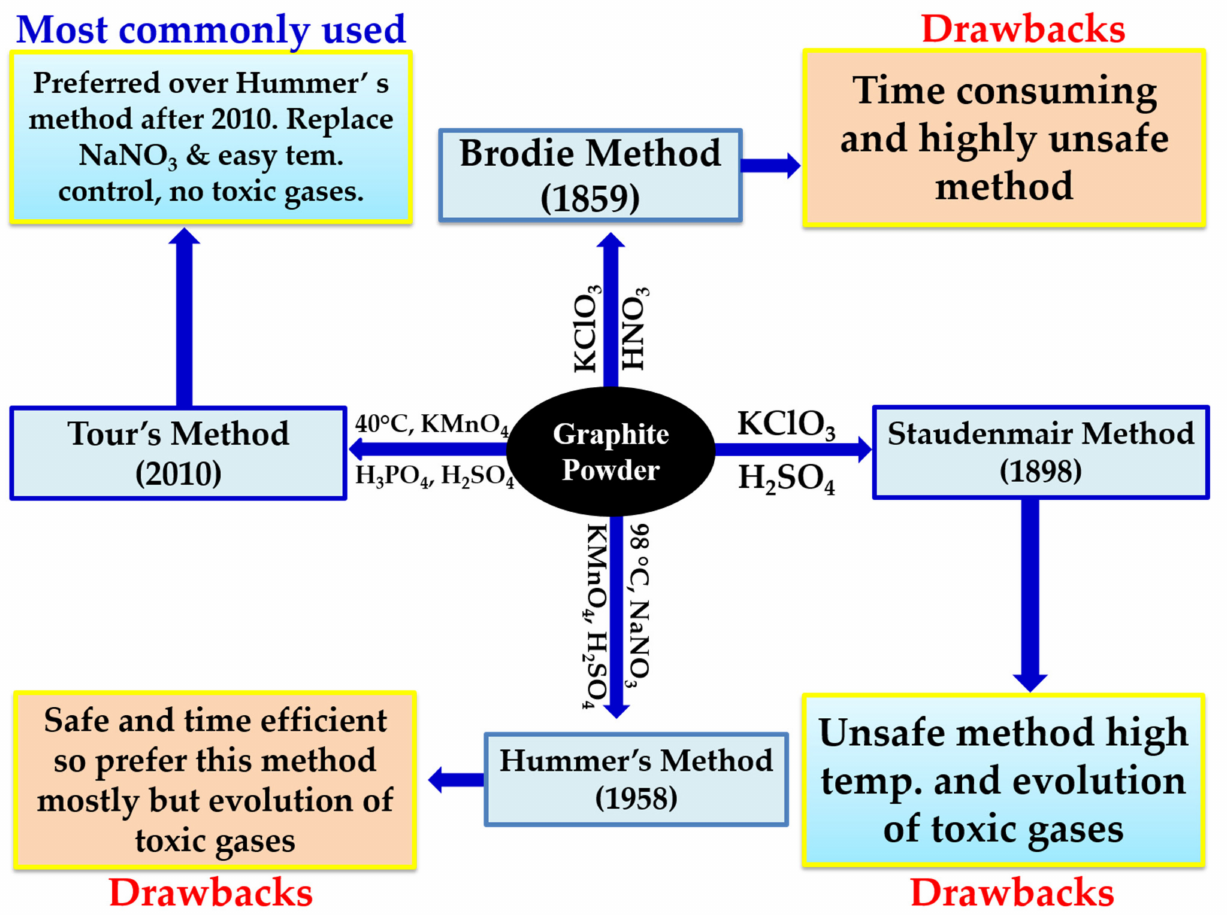
Figure 11. Schematic representation of the synthesis of graphene oxide with different methods. In 1958, Hummer reduced the reaction time from 2 days to 12 h by using KmnO 4 as the oxidizing agent instead of KclO 4 , followed by the addition of sodium nitrate, but the problem of toxic gases still remains a challenge [98]. Further, in 2010, at Rice University, Tour’s group [102] replaced sodium nitrate with phosphoric acid and increased the amount of KmnO 4 . This improvement made the process eco-friendly, as it completely stops the release of toxic gases such as NO 2 , N 2 O 4 or ClO 2 , along with easy temperature control and better yield [102]. In addition to this, the GO suspension obtained was treated with hydrogen peroxide (H 2 O 2 ) to eliminate all impurities due to permanganate and manganese dioxide. Furthermore, the final color of the product GO varies from army green to light yellow, depending on the carbon-to-oxygen ratios [113], as depicted in Table